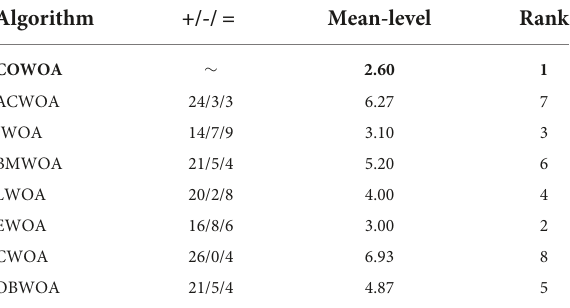
TABLE 7 Results of Wilcoxon signed-rank test.